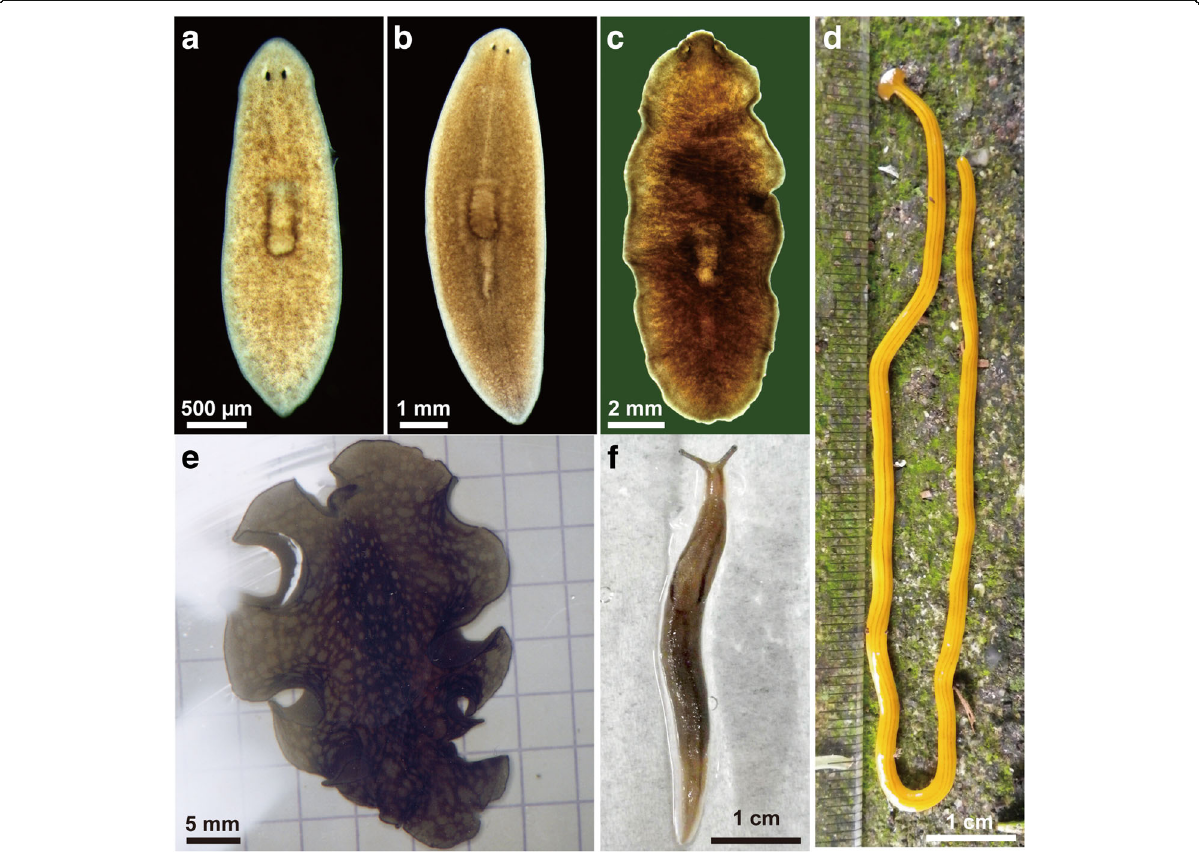
Fig. 1 Images of the five species used in this study. a The asexual worm (OH strain) of the freshwater planarian Dugesia ryukyuensis (Tricladida, Continenticola, Dugesiidae). b The sexual worm of D. ryukyuensis . c The freshwater planarian Bdellocephala brunnea (Tricladida, Continenticola, Dendrocoelidae). d The land planarian Bipalium nobile (Tricladida, Continenticola, Bipaliidae). e The marine flatworm Thysanozoon brocchii (Polycladida). f The slug Ambigolimax valentianus